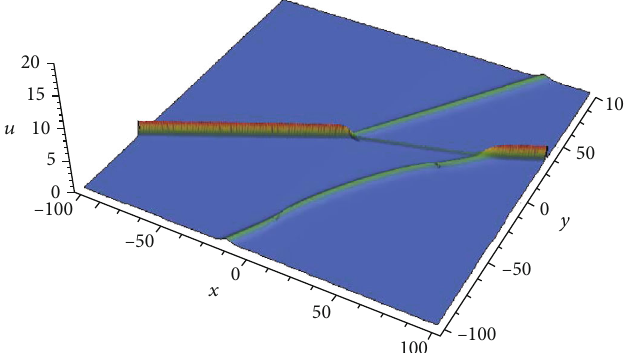
= 0 : 2 , k = 1 : 2 , k = 2 : 2 , 1 2 3